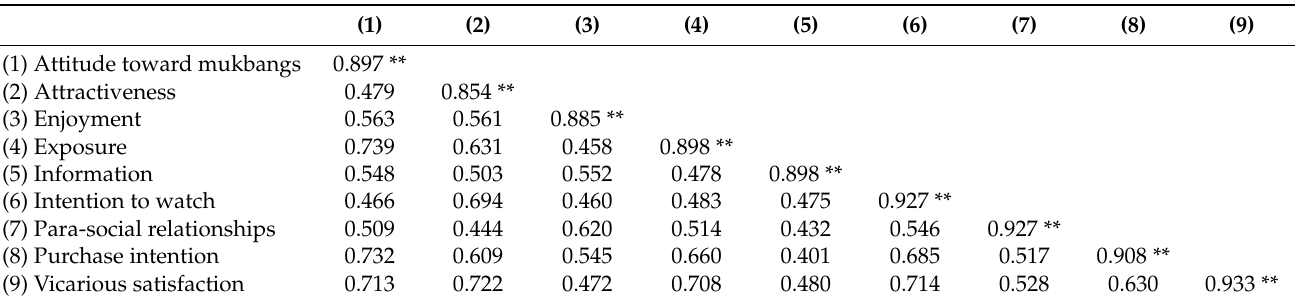
Table 2. Correlations among